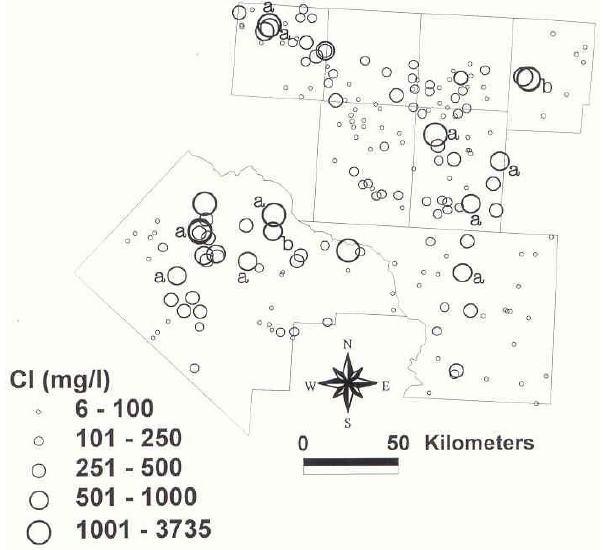
FIGURE 2 . Map of chloride concentrations; a and b designate wells with >500 mg/l chloride and <300 or >2000 chloride/bromide ratios,